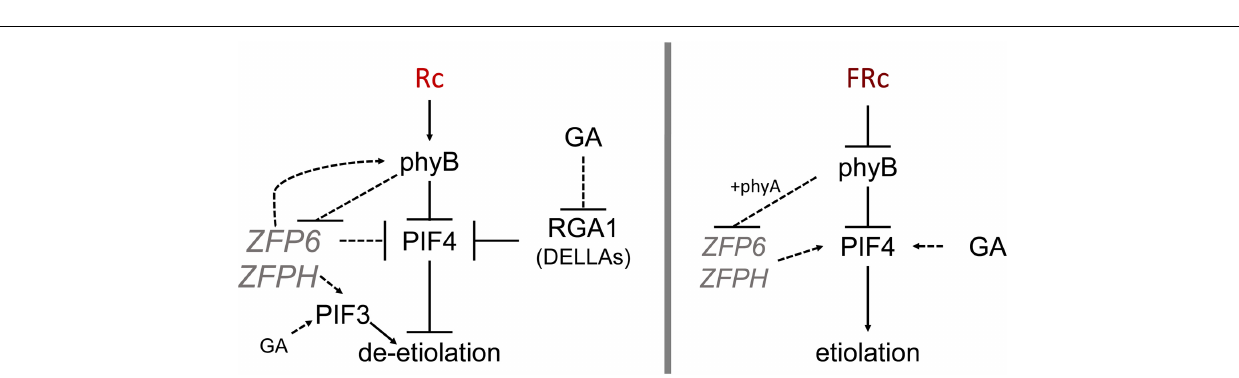
FIGURE 8 | Model showing ZFP6 genetic interactions in red and far-red light. Published literature has demonstrated that phyB destabilizes PIFs while RGA1 (a DELLA family protein) blocks PIF4 (prior relationships represented with solid black lines). In red (R) light (left), phyB reduces ZFP6 expression. In turn, ZFP6 downregulates PIF4 and induces PHYB (relationships established in this work represented with dotted lines) in R light likely providing a feedback loop to aptly modulate hypocotyl lengths in response to light. ZFPH serves to promote PIF3 in R light, and PIF3 is also promoted by GA in R. In the presence of the growth-promoting GA hormone in R light, GA reduces RGA1 transcripts, which allows PIF4 accumulation and promotion of elongation in presence of GA. In far-red (FR) light (right), phyB together with phyA reduce ZFP6 (and ZFPH ) expression. In the presence of the growth-promoting GA hormone in FR, GA promotes PIF4 accumulation leading to elongation typical of